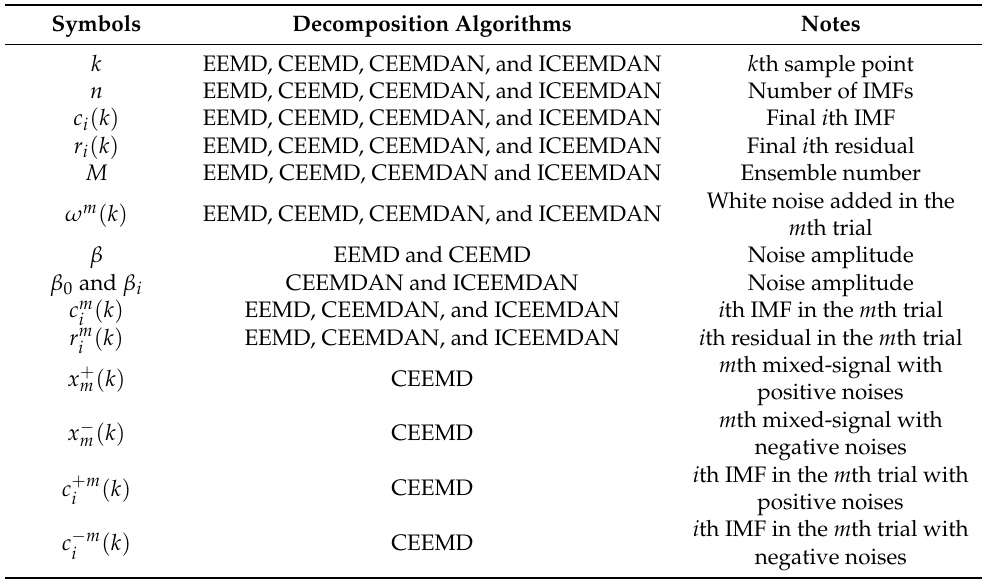
Table 2. Parameters used in EMD and the four noise-assisted EMD algorithms. Symbols Decomposition